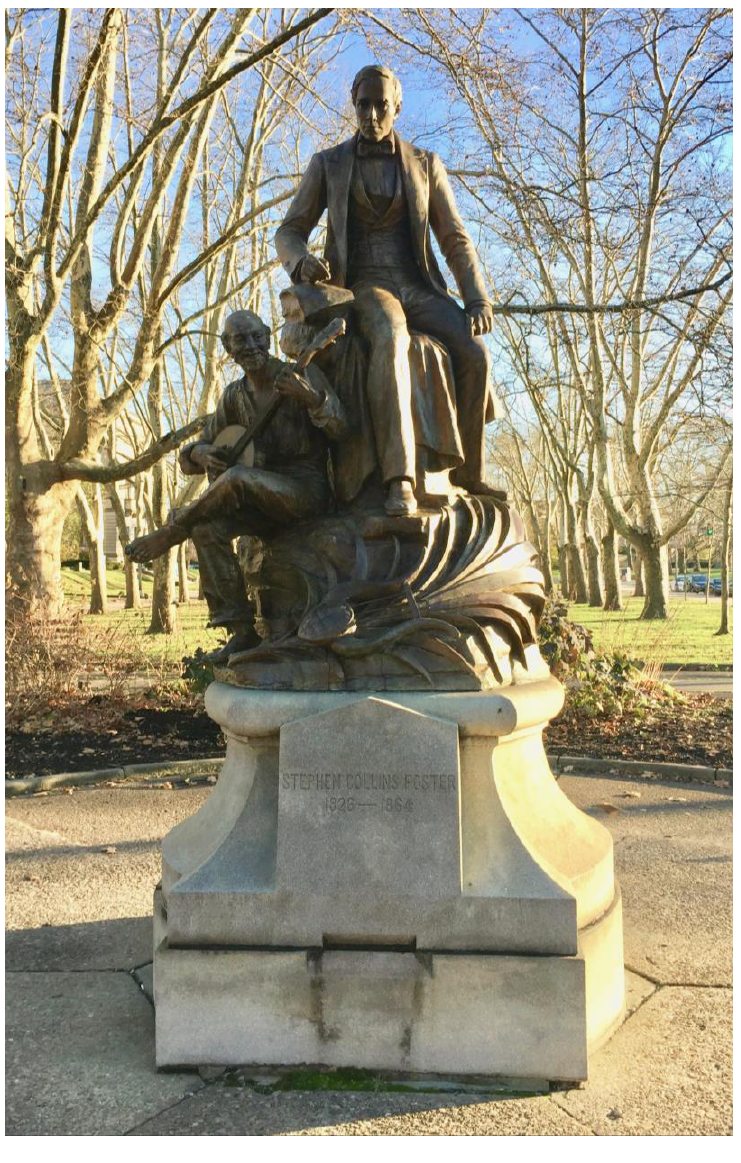
Guiseppe Moretti, bronze, 10 ft high, originally Highland Plaza, Oakland, Pittsburgh, Pennsylvania. Photo by Rae Di